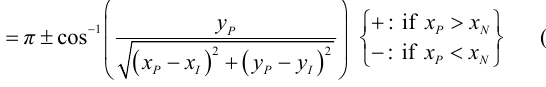
Figure 2. The tilt angle is the complement of the depression angle, which is computed according to equation (3). The swing angle is the angle measured clockwise from the positive y c -axis to the principal line, at the side of the nadir point; y c -axis has its origin at the principal point and is directed upwards. The first step for the computation of the swing angle is the determination of the intersection point ( x I , y I ) between the principal line and the upper border of the image (x-axis). Then, the swing angle is calculated geometrically, according to equation (5). The azimuth angle is computed via equation